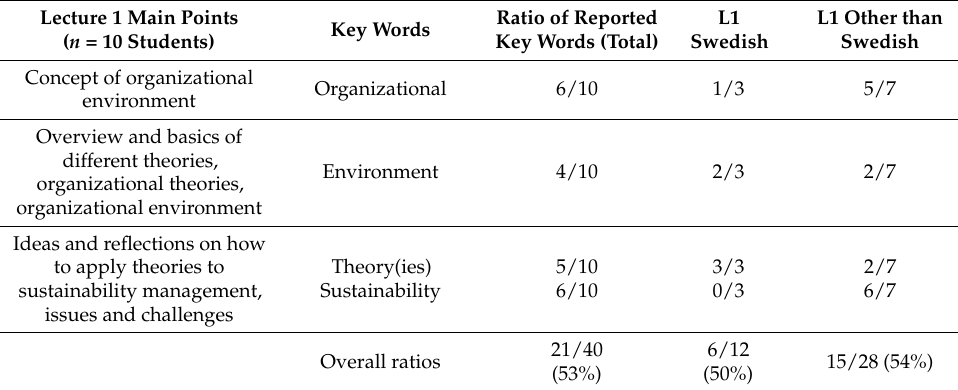
Table 2. Lecture 1 main idea key words comparison.